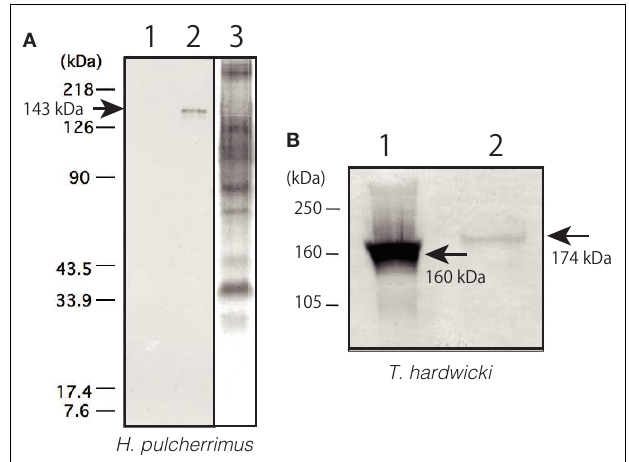
FIGURE 3 | Immunochemical property of Epith-2 of H. pulcherrimu s (A) and T. hardwicki (B) analyzed by immunoblotting . (A) Immunoblotting of Epith-2 extracted in water (lane 1) and in non-ionic detergent 1%Triton X-100 (lane 2) of swimming blastulae.Whole embryo lysate stained with concanavalin A (lane 3). (B) M r of Epith-2 glycoprotein under non-reducing conditions (lane 1; 160kDa region) and reducing conditions (lane 2; 174kDa